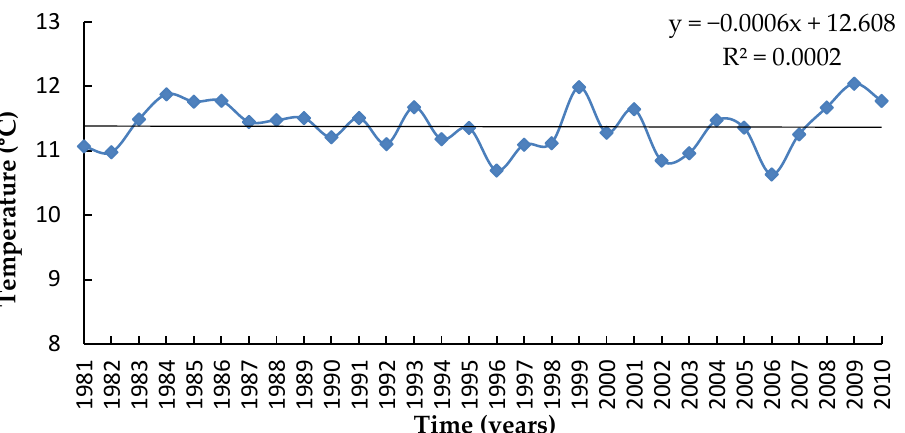
Figure 1. Observed average daily minimum temperature (May–August) for Ceres for the period 1981–2010.